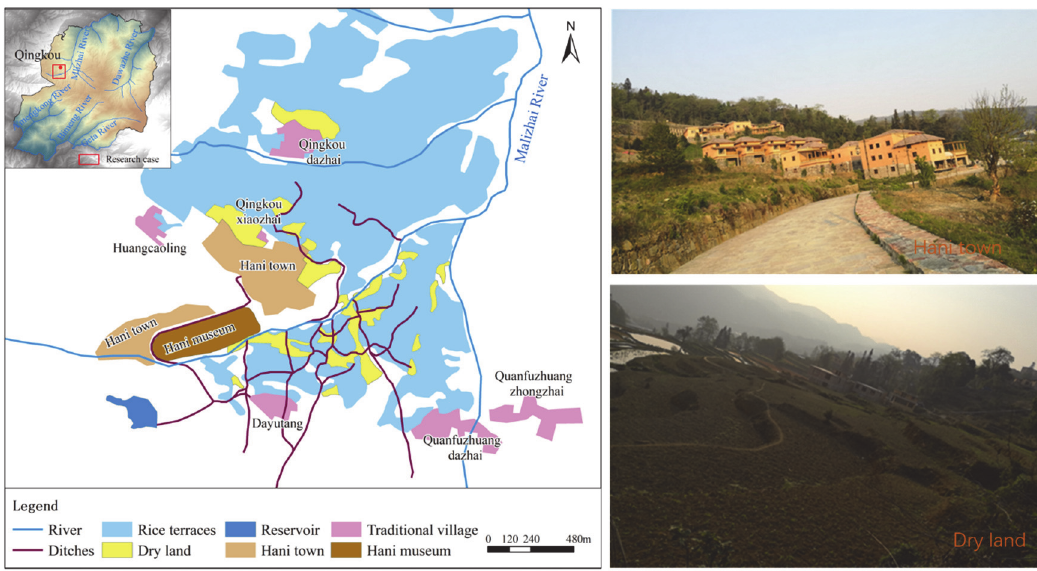
Figure 3. The locations of Hani Town, Hani Museum and the dry land.